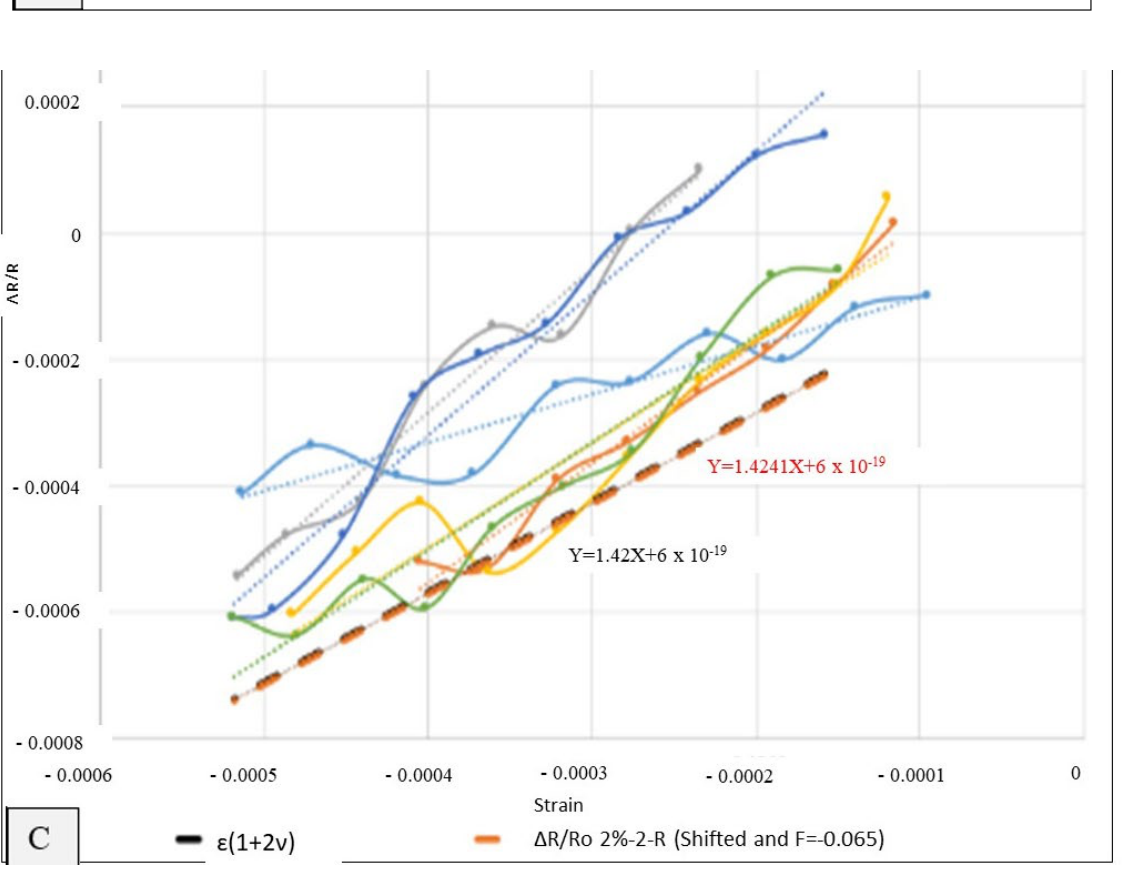
Figure 9. Elasto-Electric Parameter X–Y Scatter Plot with Mechanical vs. Electrical Measurements for Load Test 1 for (( A ) Left Electrode, ( B ) Middle Electrode, and ( C ) Right Electrode).